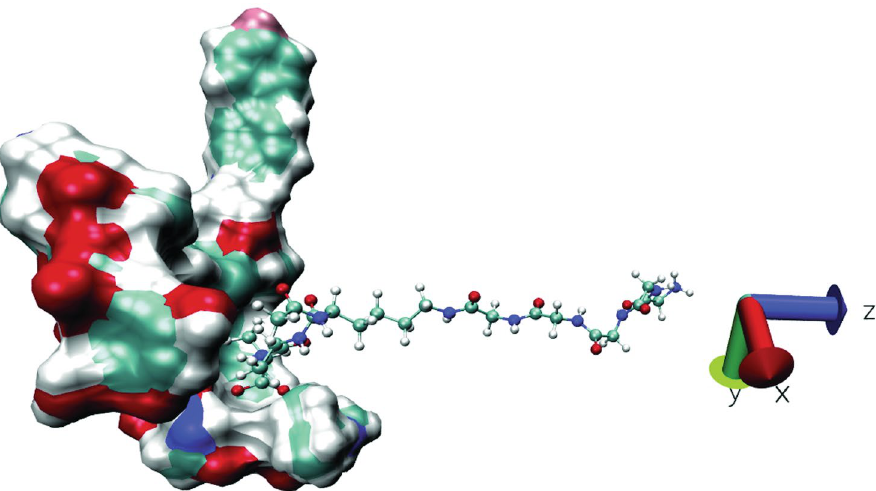
Figure 8. Representation of pulling simulation for (desleucyl)glycopeptide–PG complexes. The PG was pulled away from the (desleucyl)glycopeptide to generate series of configurations along the reaction coordinate